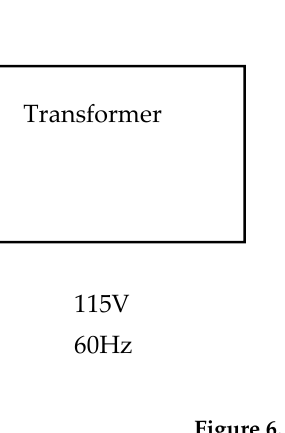
Figure 6. Resistive barrier discharge [29].